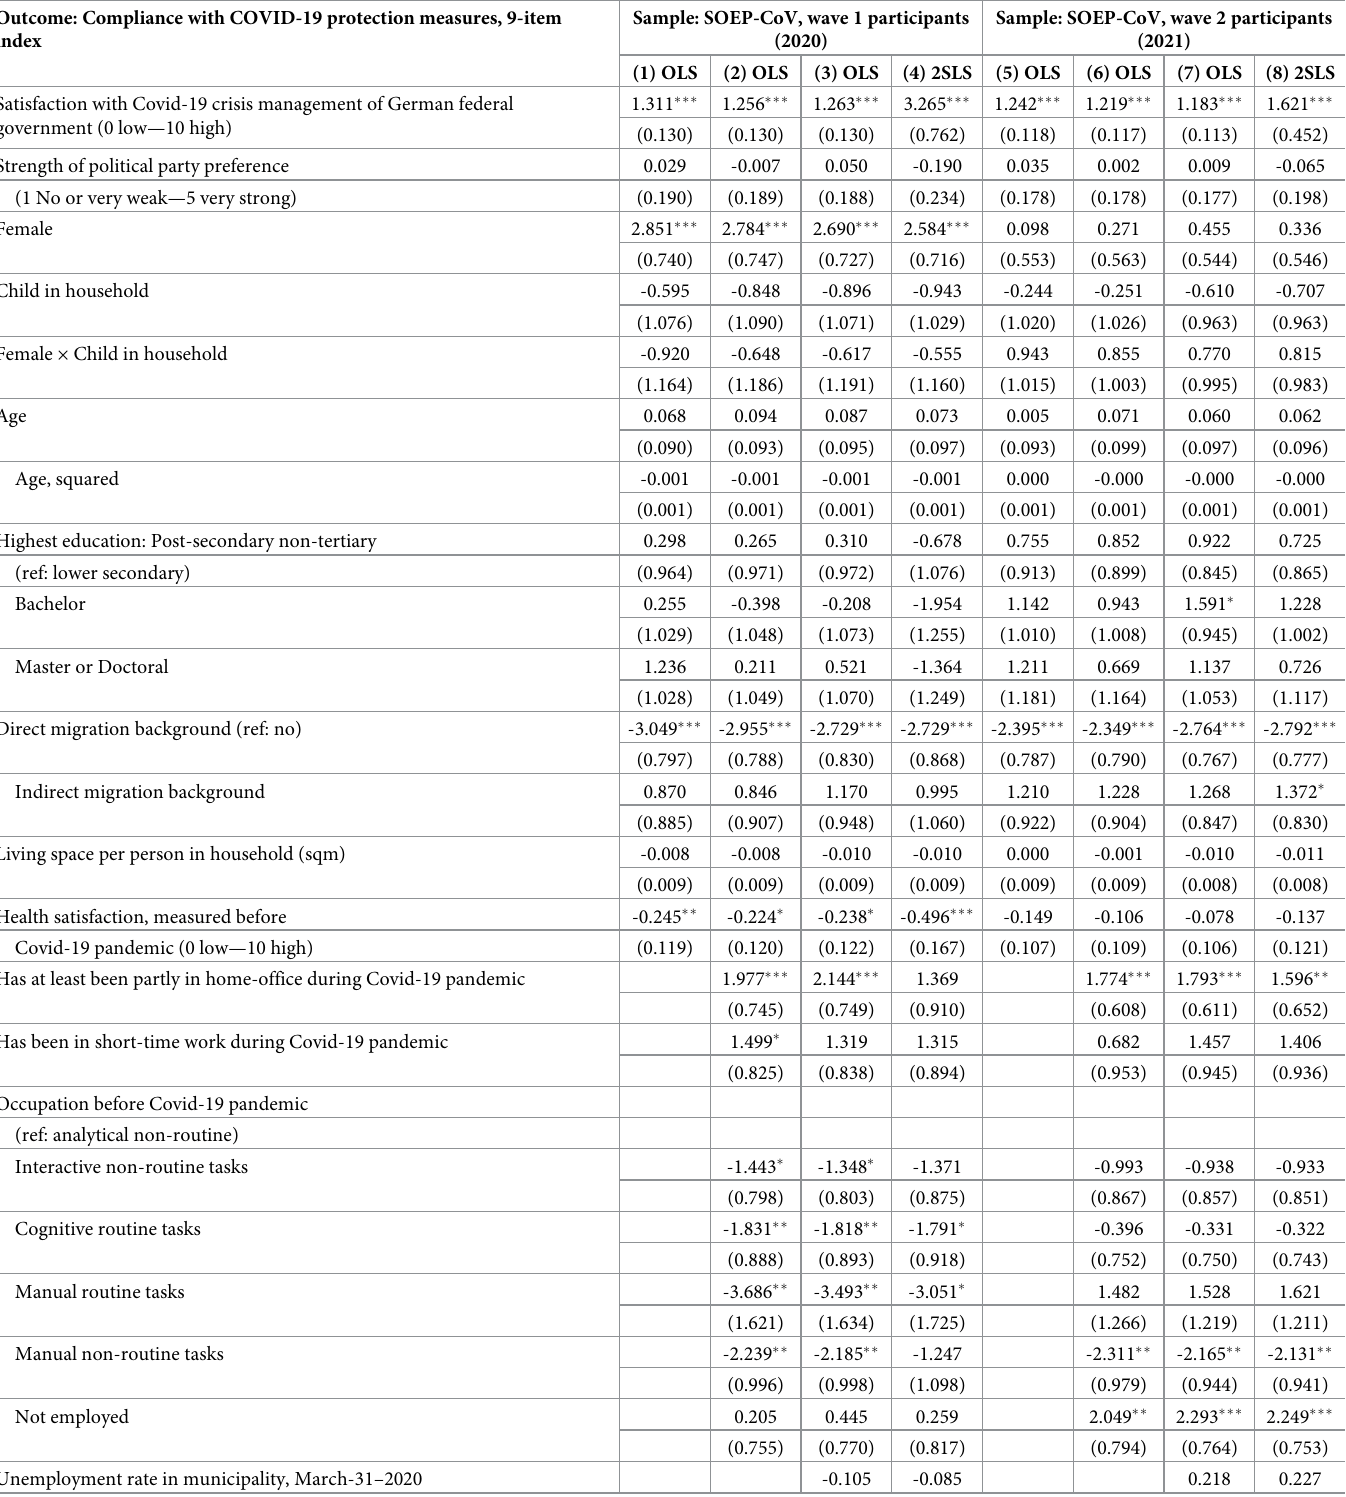
Table 3. Compliance and satisfaction with crisis management, OLS & 2SLS